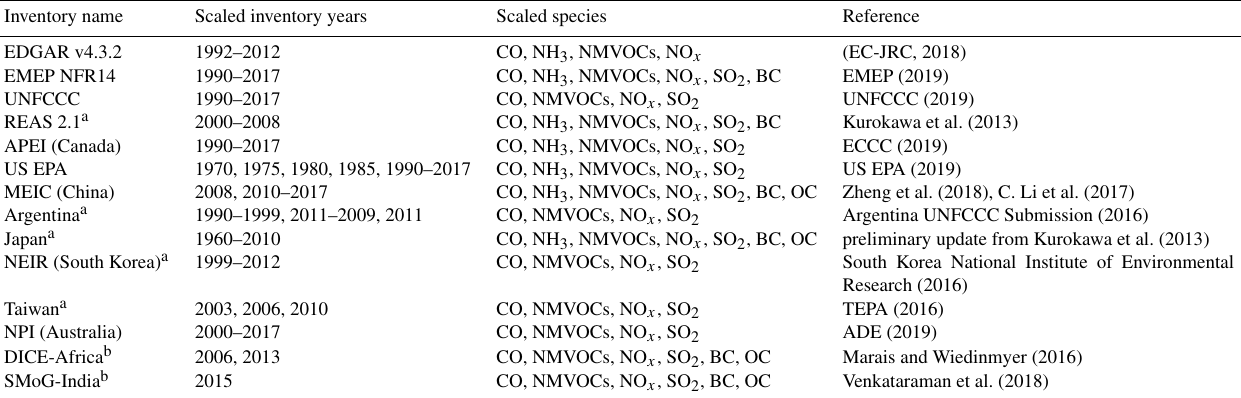
Table 3. Scaling